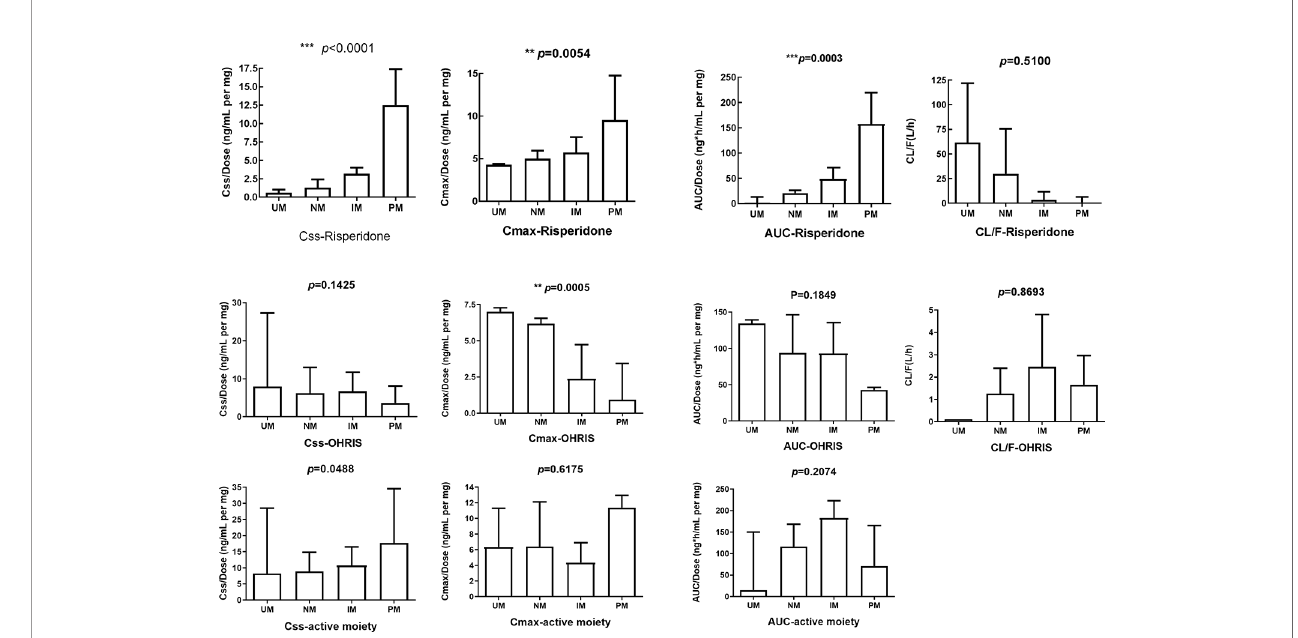
FIGURE 3 | Effects of CYP2D6 metabolizer phenotype on selected pharmacokinetic parameters. All parameters, except apparent oral clearance, were dose- adjusted. The fi rst row represents pharmacokinetic parameters for risperidone, the second for 9-hydroxyrisperidone, and the third for active moiety of risperidone. There was only one paper reporting the CL/F of the active moiety of risperidone, therefore, this was not pooled. Css, Steady state dose-normalized; Cmax, peak dose-normalized plasma; AUC, dose-normalized area under the plasma concentration; CL/F, apparent oral clearance. Error bars represent standard deviations. **means p < 0.01, ***means p <